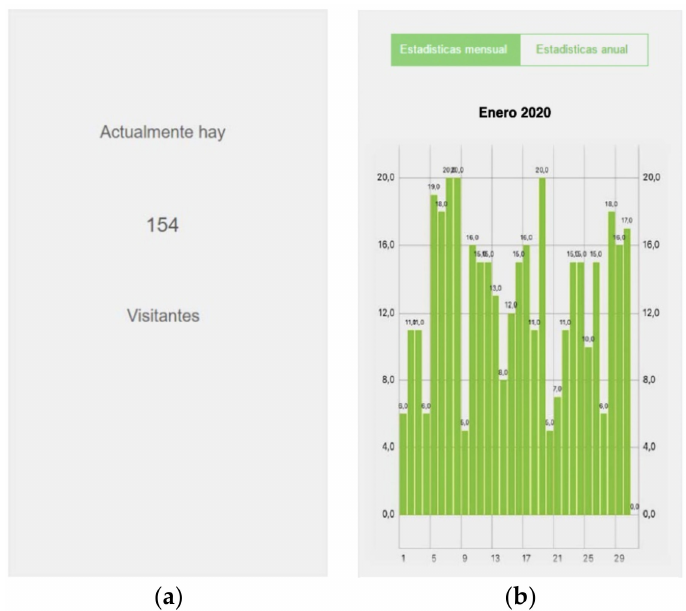
Figure 8. ( a ) Screen shot with the number of users in a defined space in real time. ( b ) Screen shot of the statistics on